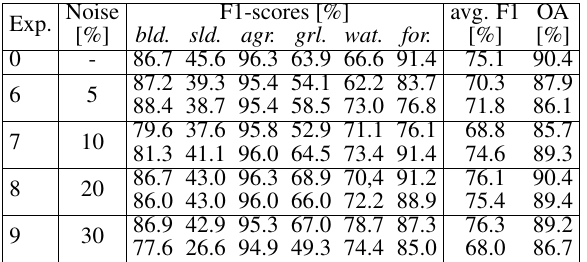
Table 4. Evaluation of land cover classification different amounts of simulated noise based on reference R 1 . The first row corresponds to experiment 0 in table 3. OA: Overall Accuracy.